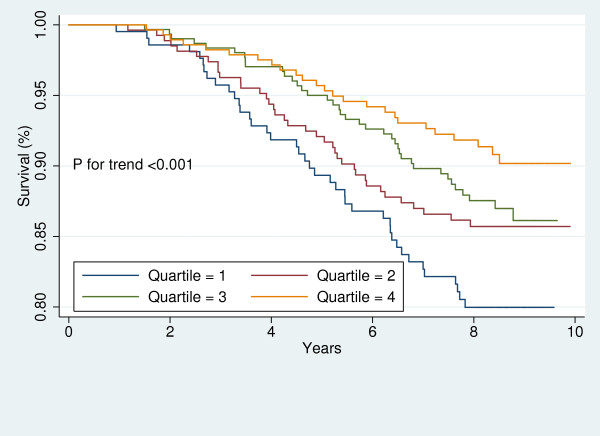
Kaplan-Meier curves for all-cause mortality across LAP quartiles in men with global CVD risk 20% or more.